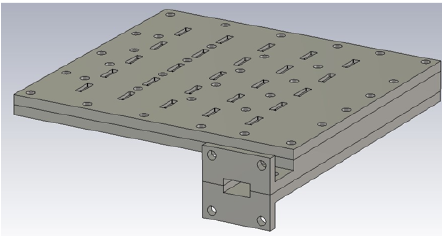
Figure 1. Perspective view of the designed 2D transverse waveguide slot array without